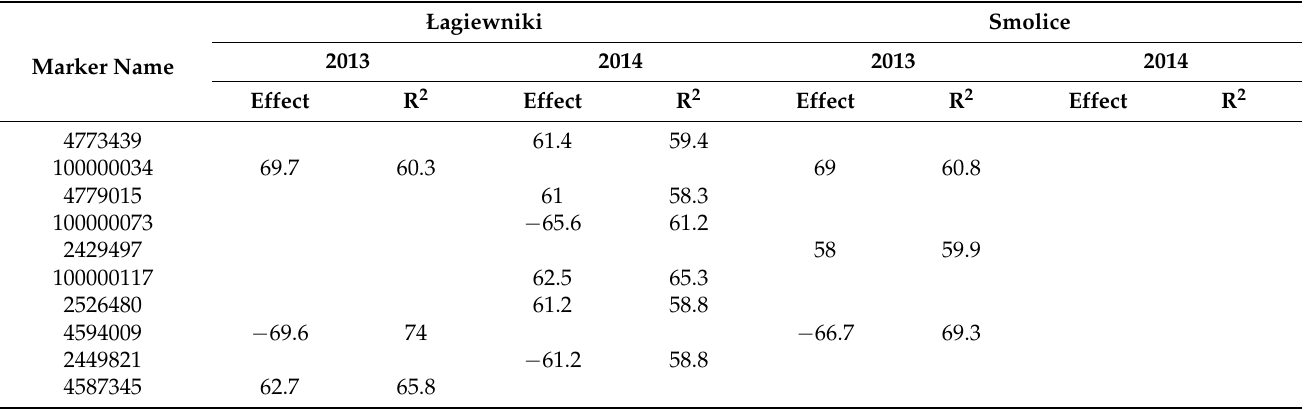
Table 8. Molecular markers (SilicoDArT) significantly (LOD > 3.0) associated with the heterosis effect of weight of 1000 grains